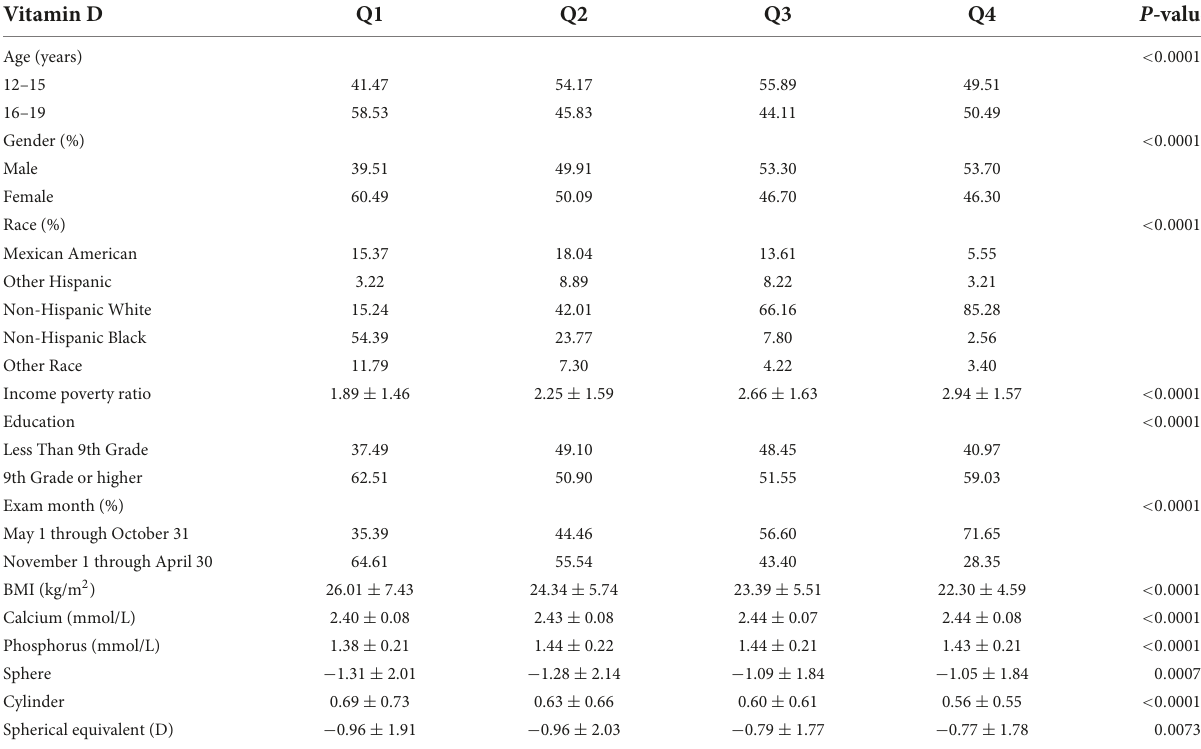
TABLE 1 Description of 5,901